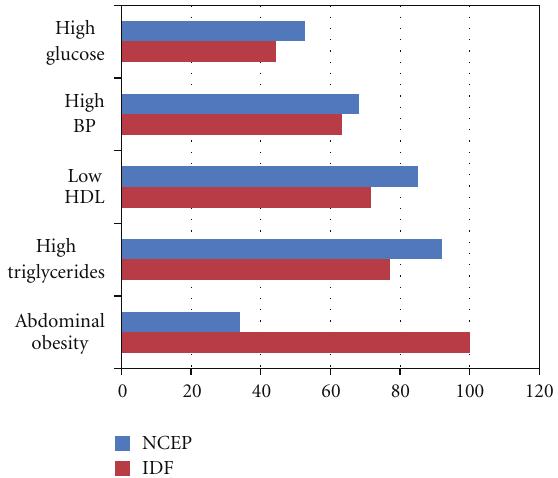
Figure 2: Percentage of individual risk factor among participants with